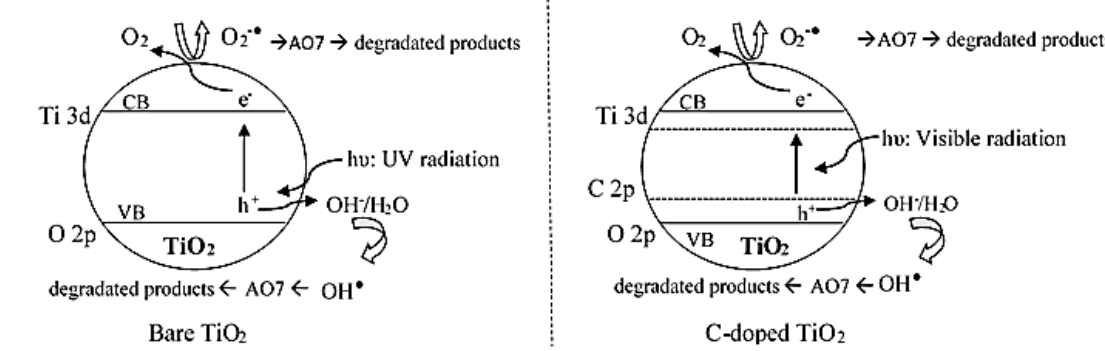
ff erent photocatalytic mechanisms for the solids activation under Scheme 2. Different photocatalytic mechanisms for the solids activation under radiation. Scheme 2. Di